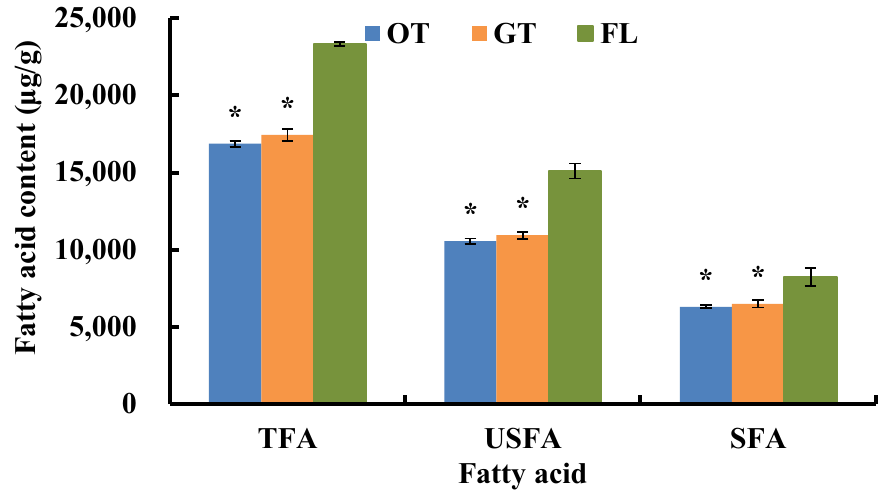
Figure 1. Fatty acids content of different tea samples. TFA, USFA, and SFA indicate total fatty acids, unsaturated fatty acids, and saturated fatty acids, respectively; * indicates the difference level of fatty acids between fresh leaves (FL) and oolong tea (OT) or green tea (GT) ( p < 0.05).